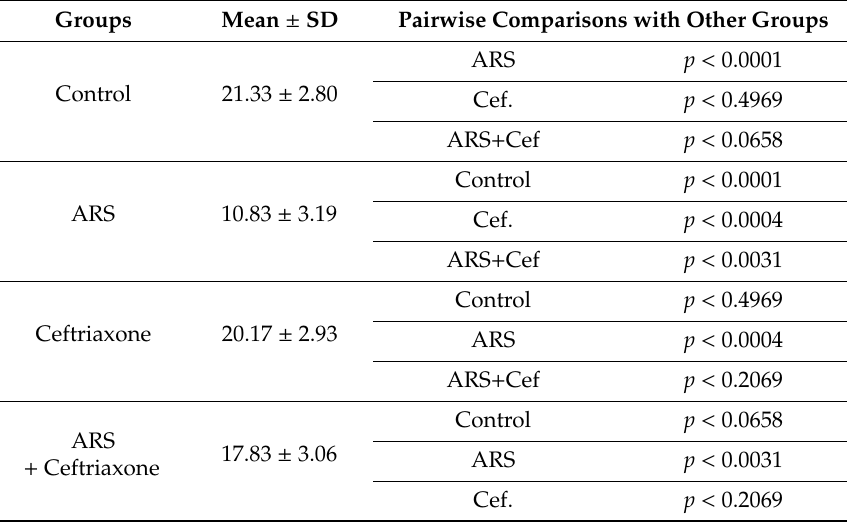
Table 7. Morphometric analysis of the Purkinje cells